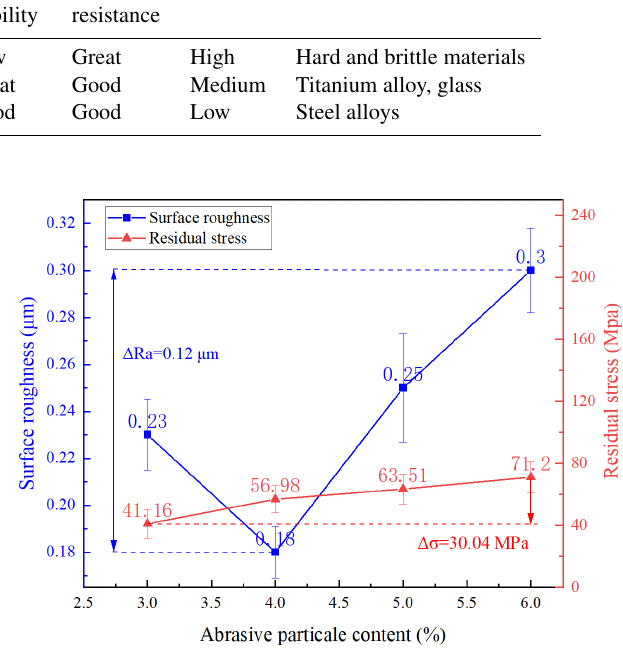
Figure 7. Effect of different polishing abrasive contents on surface roughness of the